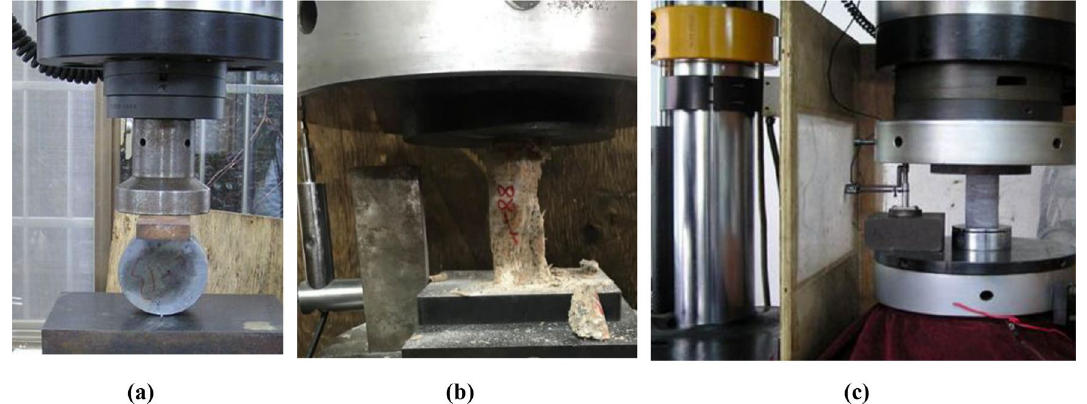
Figure 22. The rock mechanics tests in the laboratory: ( a ) Split tension test, ( b ) Uniaxial compression experiment, ( c ) Rock loading and unloading test.